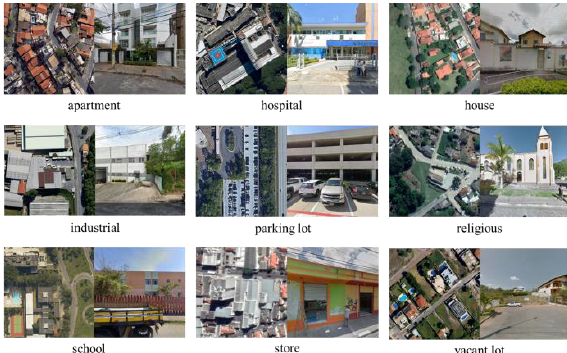
Figure 6. Examples of instances taken from CV-BrCT (The left side of the image pair is aerial image, and the right side is ground street view)